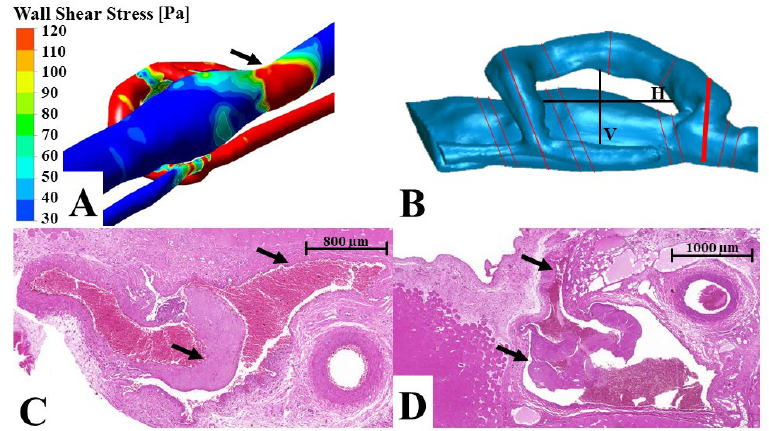
Figure 5. The junction site of the superficial inferior epigastric vein and the femoral vein—comparison of the flow simulation and the histology using a representative figure. ( A ) Flow simulation image of a fresh arterio-venous fistula. The arrow points to the vessel junction. ( B ) A 3D model of the vessels. The red lines show the plane where the tissue samples were sliced for his- tology. The black lines V (vertical) and H (horizontal) were used to evaluate the shape change of the fistula. The thick red line is represented in image ( C ). This is the venous junction of the super- ficial inferior epigastric vein and the femoral vein. ( C , D ) Histological slides of the superficial infe- rior epigastric vein–femoral vein junction. The upper arrow shows the superficial inferior epigas- tric vein, while the lower arrow shows the intimal hyperplasia formation in the femoral vein. Magnification: 50×.